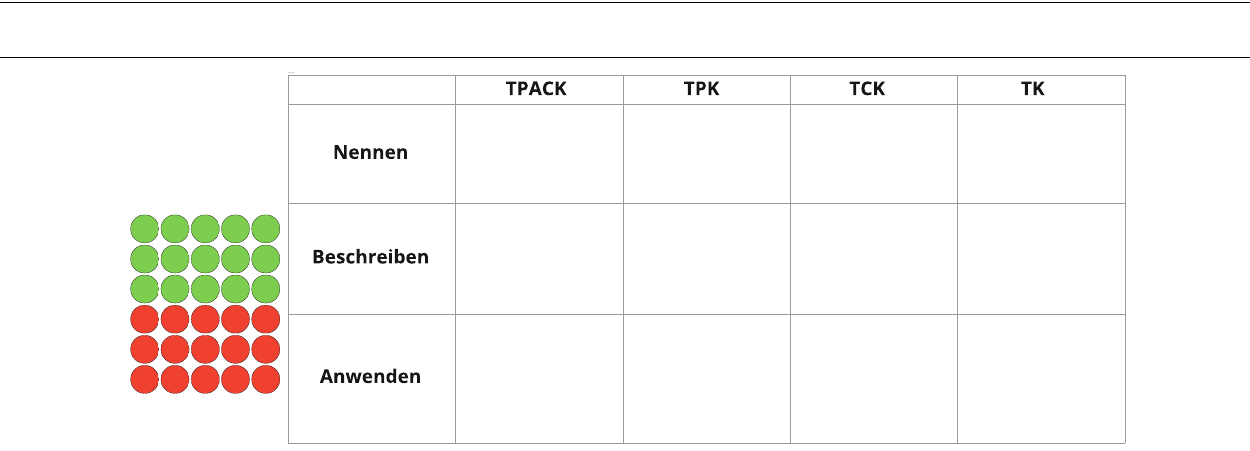
Frontiers in Education |